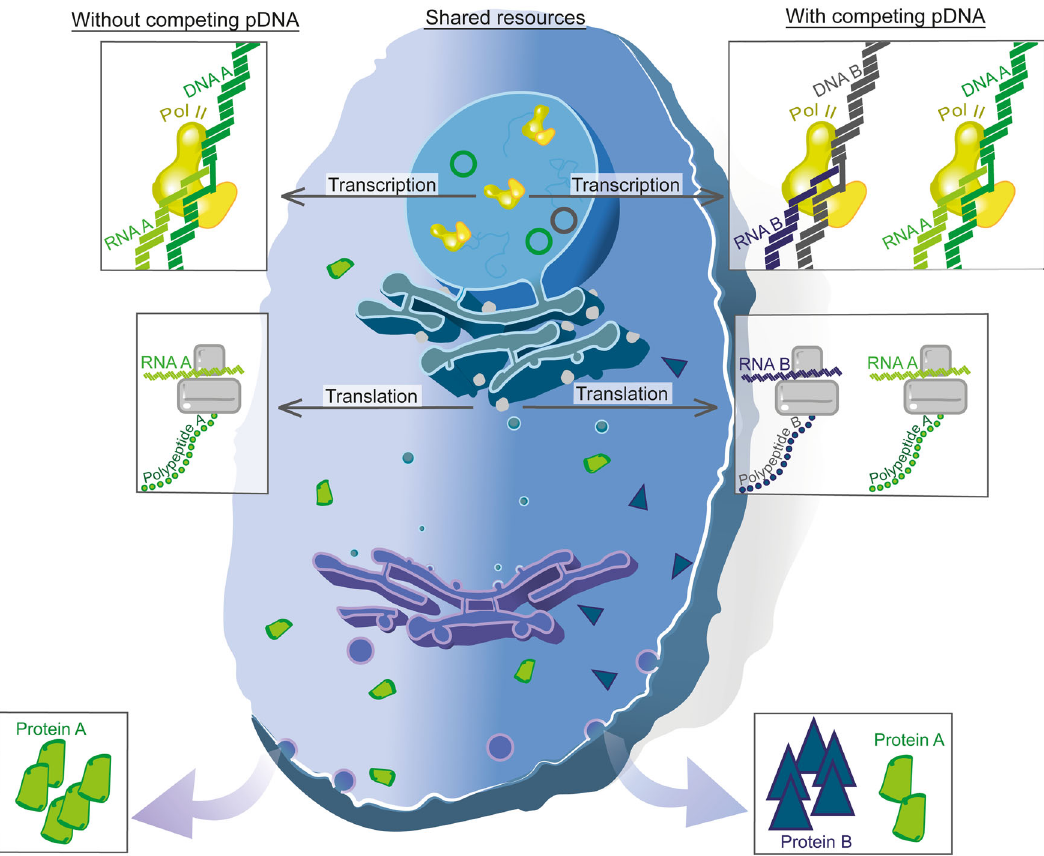
Fig. 1 A comparison of resource allocation in mammalian cells upon transfection of a genetic construct with and without a co-expressed control. Two scenarios are shown in parallel where a plasmid (pDNA) harbouring Protein A is transfected alone (left) or co-transfected with Protein B (right). In the nucleus, pDNA are processed by a fi nite number of RNA polymerase II (Pol II) molecules; therefore heterologous (A and B) and endogenous genes must compete for its availability. In a scenario with greater competition (right), less mRNA is transcribed from DNA A compared to a scenario with less competition (left). To compound this issue, cells also contain a fi nite number of ribosomes. As such, competition for translational machinery leads to unpredictable production of A and B